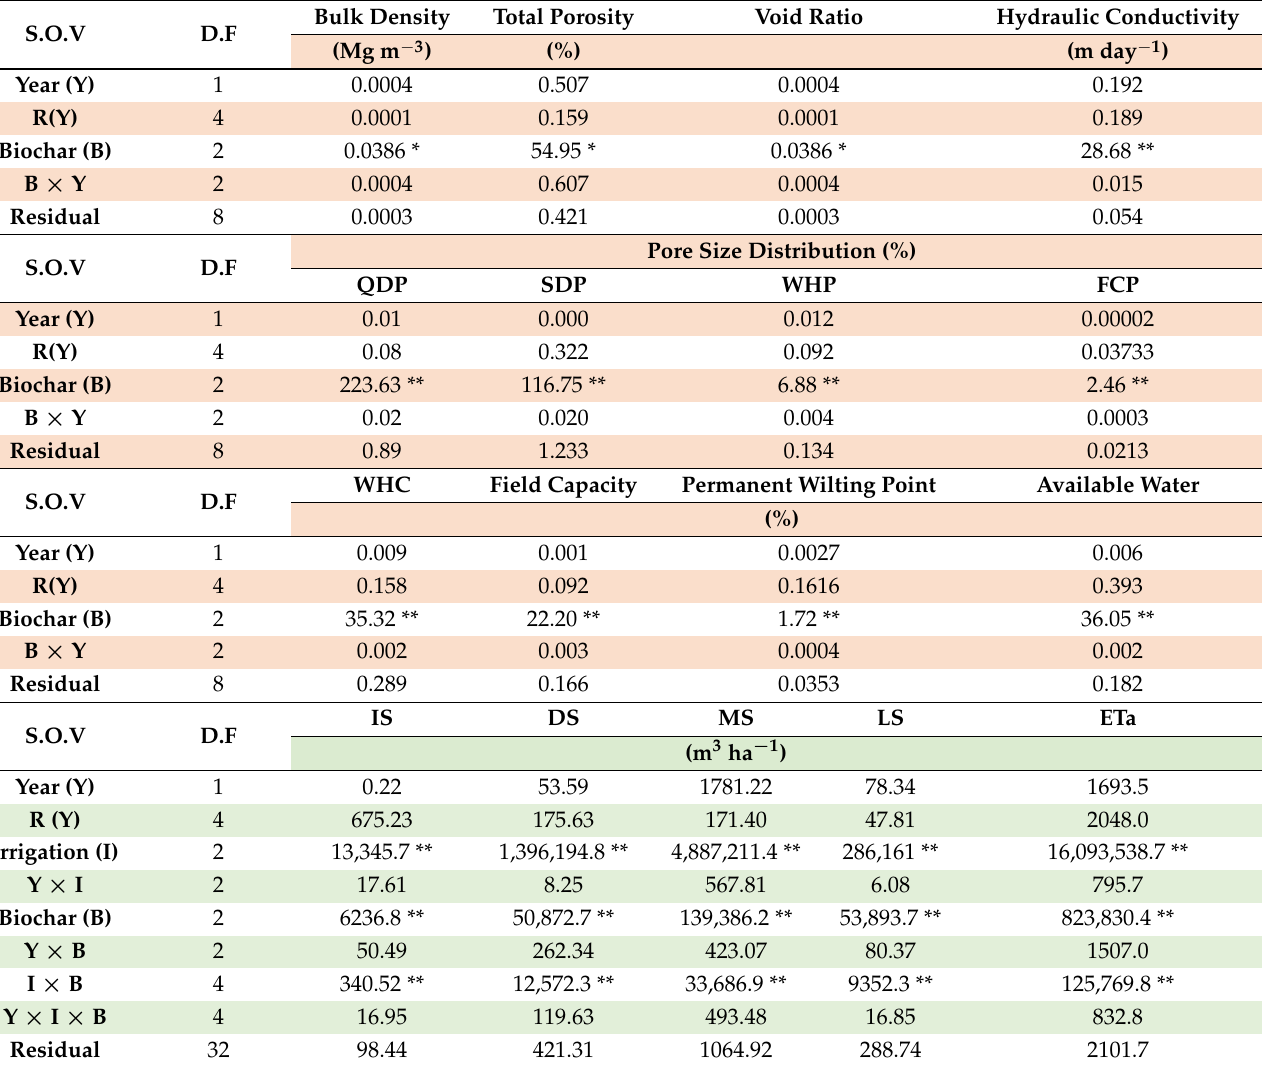
Table 4. Mean squares for the combined analysis of the soil traits as affected with biochar soil supple-mentation (orange colour). Mean squares of the combined analysis for the main effects of irri-gation, biochar, and the interaction for studied traits (green